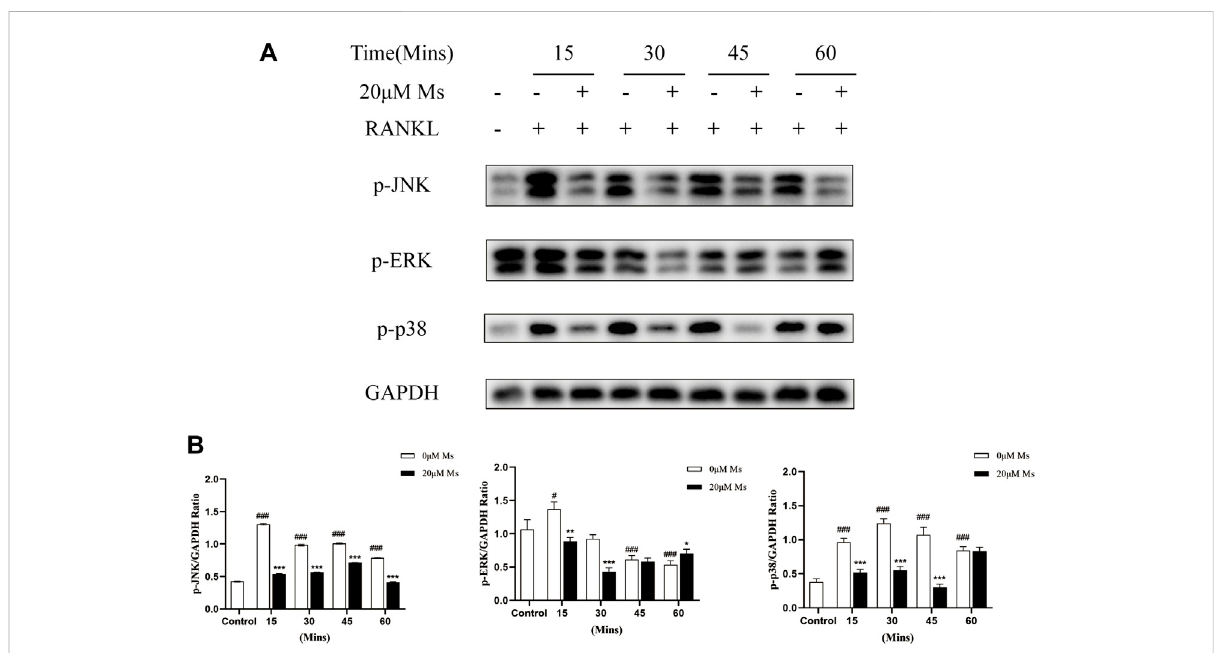
FIGURE 5 Ms inhibits RANKL-induced osteoclast differentiation by suppressing MAPKs signaling pathways. RAW264.7 cells were treated with or without Ms (20 μ M) in the presence of RANKL. Protein levels of MAPKs activation, including JNK, ERK and p38, were detected by western blot at 0, 15, 30, 45and60 min.Theresultswereexpressedasmeans±SDfromthreeindependentexperiments.# p < 0.05,## p < 0.01and### p < 0.001vs.Control group (RANKL-, Ms-); * p < 0.05, ** p < 0.01 vs. *** p < 0.001 vs. corresponding time 0 μ M Ms group (RANKL+,